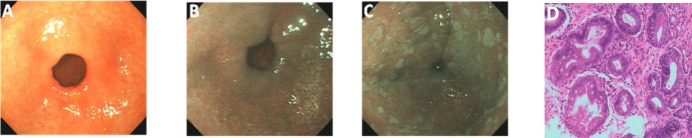
Appearance of intestinal metaplasia in the antrum of the same patient under three different endoscopic models.A, Endoscopic image in WLE shows antrum mucosa is normal. B, After being switched to the NBI model, no obvious bluish-whitish areas appear. C, The whitish patches are observed after sprinkling with acetic acid in the AA-NBI model. D, Targeted biopsy shows intestinal metaplasia of the stomach.